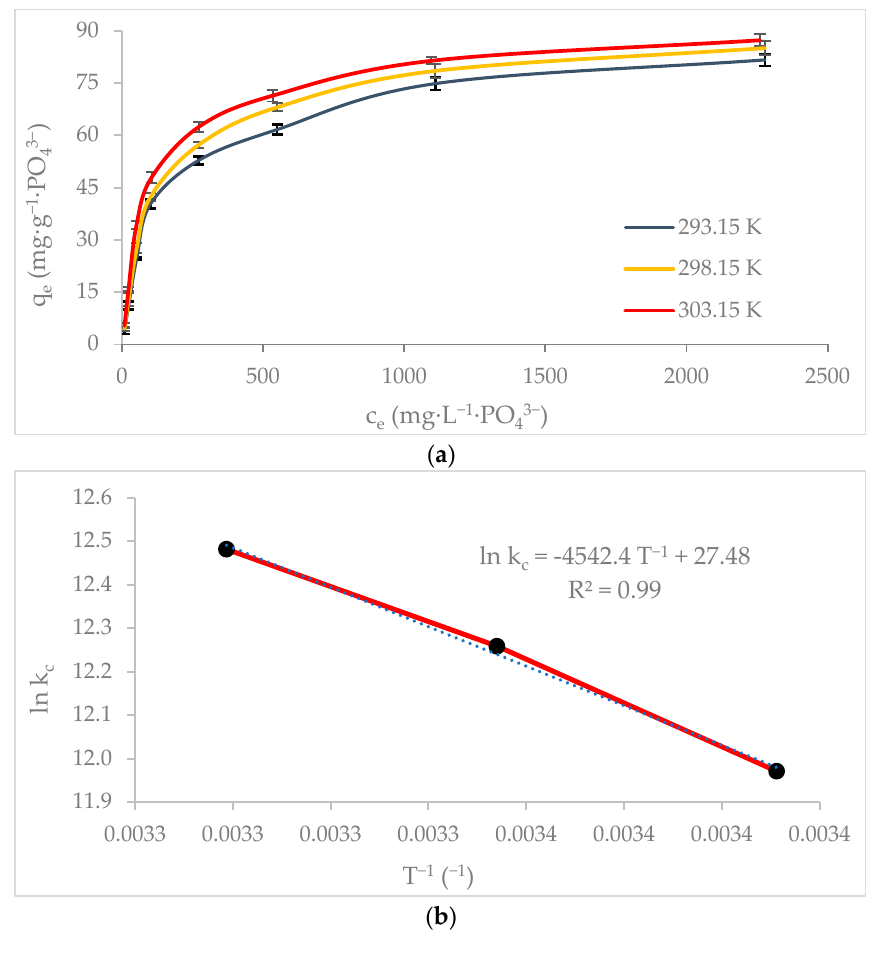
Figure 6. Equilibrium adsorption data: ( a ) isotherms as a function of the temperature and ( b ) thermodynamic study of phosphate adsorption onto Mn 2+ /Zn 2+ /Fe 3+ /Mg-Al-LDH composite. The values of maximum phosphate adsorption capacities by Mn 2+ /Zn 2+ /Fe 3+ /Mg-Al- LDH composite increased above 2% with the increase of the system temperature at 293.15, 298.15, and 303.15 K (Table 3). At the three temperatures evaluated the experimental data were best fitted to the Langmuir isotherm model and the 𝑟 (cid:3013) values were between 0 and 1, demonstrating the phosphate adsorption onto Mn 2+ /Zn 2+ /Fe 3+ /Mg-Al-LDH composite was favorable at these conditions. Table 3. Isotherm parameters of the phosphate adsorption onto Mn 2+ /Zn 2+ /Fe 3+ /Mg-Al-LDH compo- site.